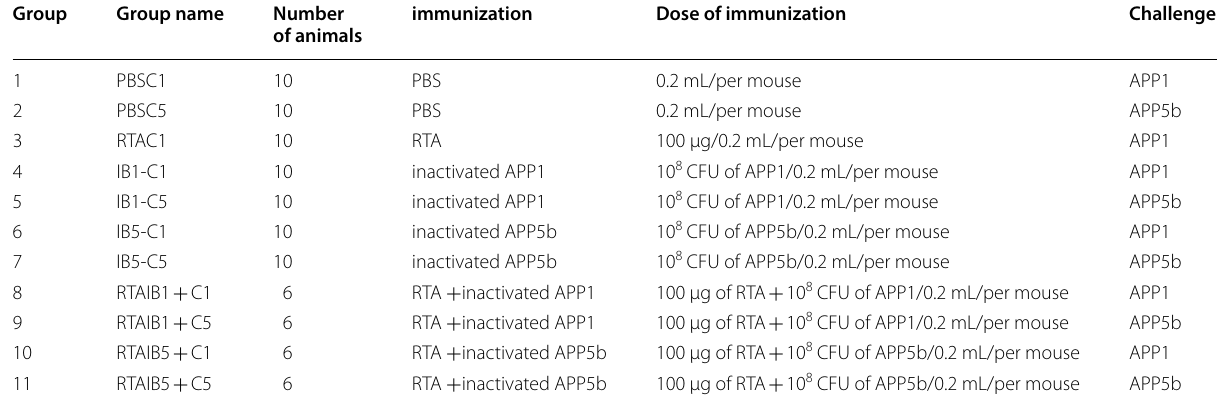
Scheme parameters: Observation of the survival rate